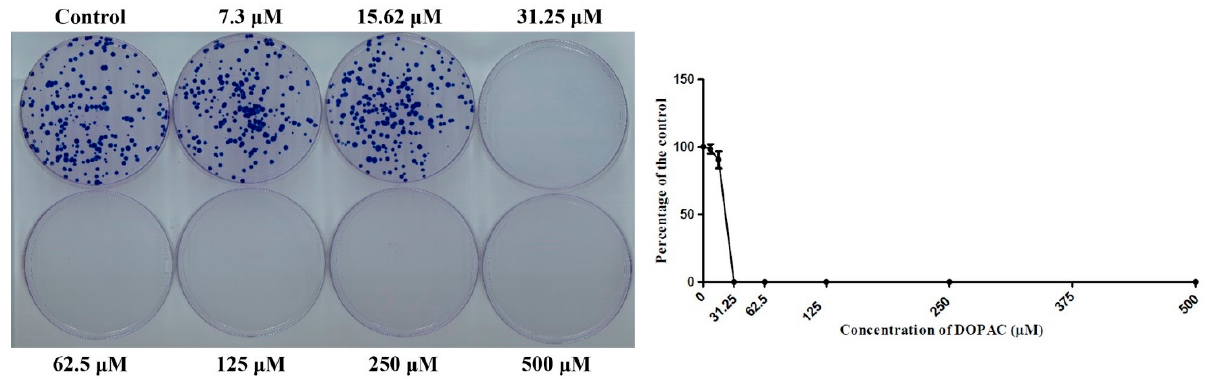
Figure 8. Effect of DOPAC on HCT-116 colony formation. Quantification of the data is shown beside the crystal violet- stained images of the colonies. The graph is represented as the mean ± standard deviation. The concentrations of the drugs used are indicated in μ M.